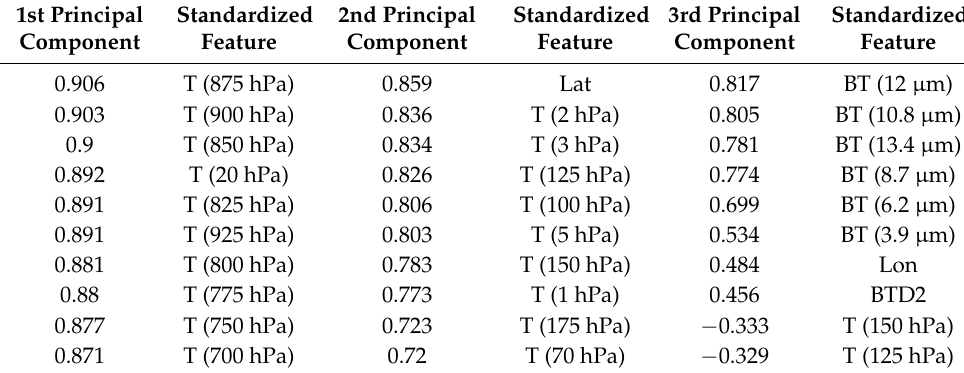
Table 8. Linear combination coefficients between the first three principal components and standard- ized features.